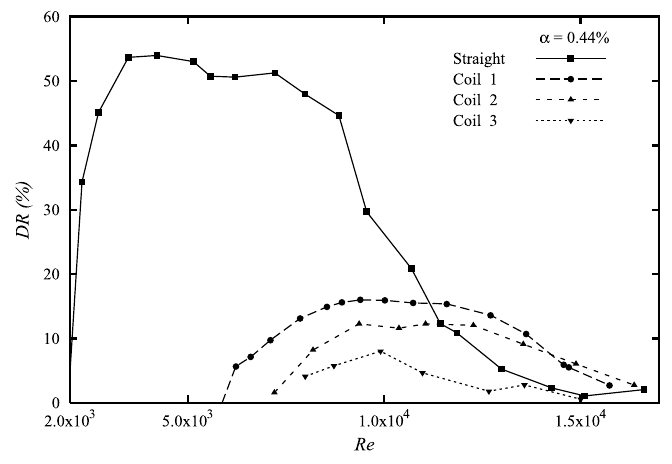
Fig. 10 Drag reduction ratio for straight and helical pipes at the same air fraction, α = 0.44%.